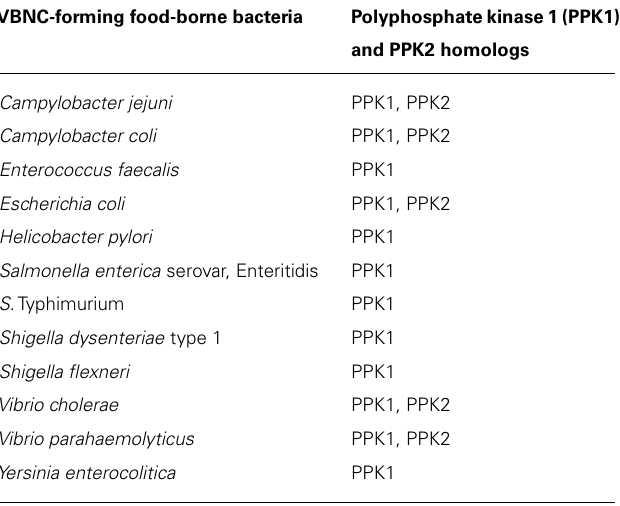
Table 2 |A list of food-borne bacterial pathogens that possess homologs of the PPK enzymes (Rao etal., 2009). VBNC-forming food-borne